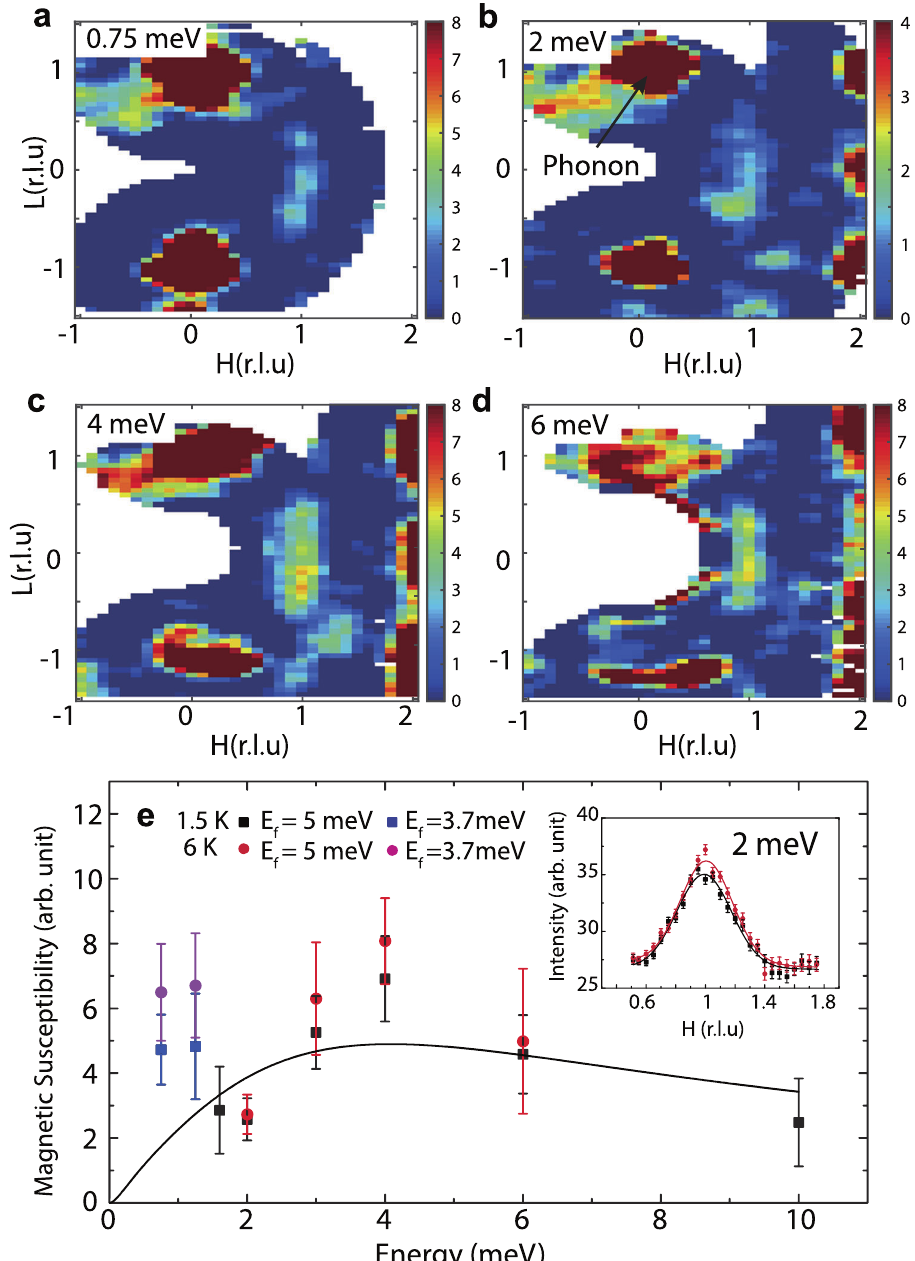
Fig. 3 Temperature dependence of the low-energy spin excitations of FeS. 2D images of neutron scattering intensity in the [ H , 0, L ] scattering plane at energies of a E = 1.25, b 2, c 4, and d 6 meV ( see supplementary information for additional data and analysis). The high scattering intensity near the Bragg peak positions of (0, 0, ± 1) is due to acoustic phonon scattering. Spin excitations in FeS form a ridge of scattering centered at (1, 0, L ) positions. e Temperature dependence of the stripe AF spin excitations at different energies below and above T c = 4 K, respectively. Spin excitations are obtained by integrating L from − 0.7 ≤ L ≤ 0.7, and fi tted with a linear background and a Gaussian peak as shown in the inset . The black line is a fi t of the energy dependence of the spin excitations with a relaxation form χ ′′ ( E ) = A Γ E /[( Γ /2) 2 + E 2 ], where Γ = 8.2 ± 2.8 meV. Inset : H -scans at E = 2 meV and at 1.5 and 6 K, respectively. The solid lines are Gaussian fi ts on a linear